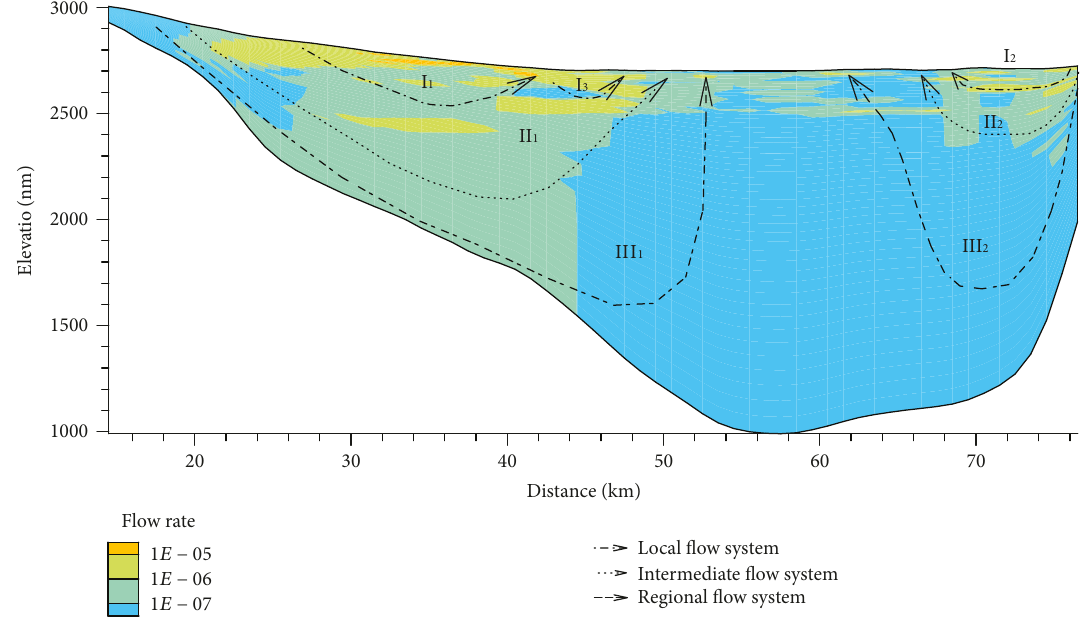
Figure 7: Simulated groundwater seepage velocities (m/s) and groundwater fl ow system